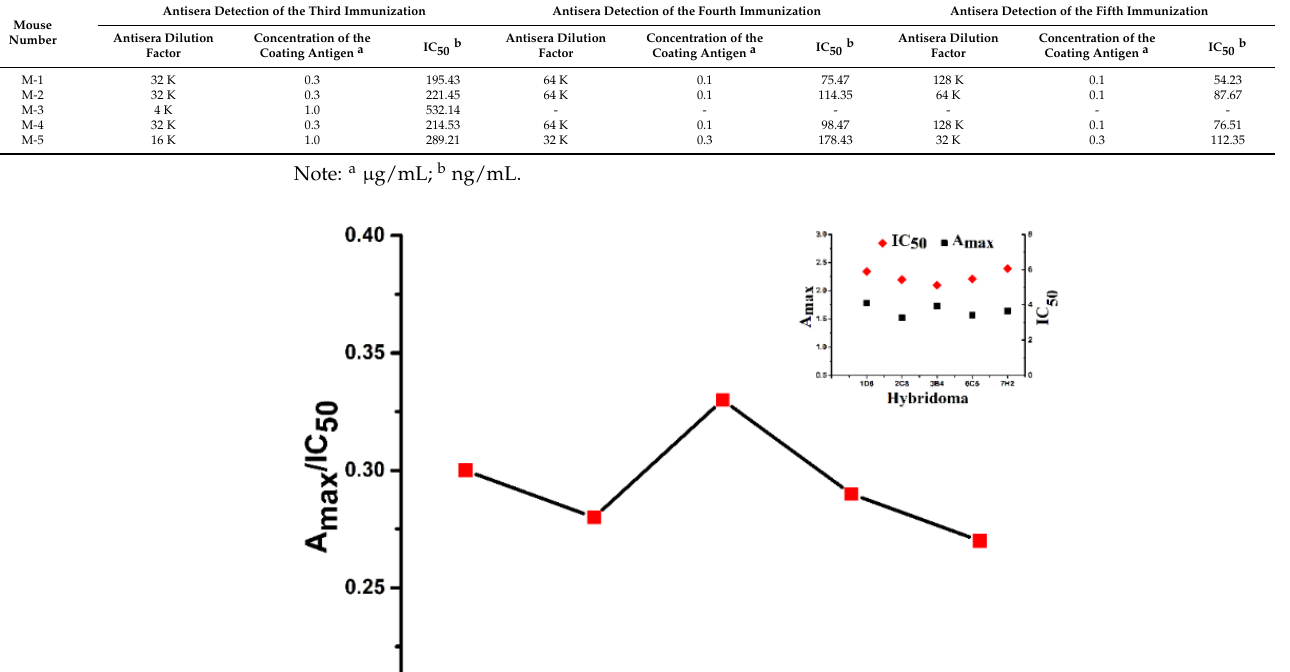
Figure 7. Characterization of the hybridoma antibody. ( A ) Isotype determination of mAb. ( B ) Affin- ity constant result of mAb. 3.5. Development and Optimization of the ic-ELISA The ic-ELISA was optimized under the optimal analysis condition, with the coating antigen and mAb concentrations for 0.1 μg/mL and 0.31 μg/ mL, respectively. The pH val- ues were known to affect the available number of sites of the antigen-antibody reaction, while the NaCl content could affect the charge of the epitope and paratope groups and then limit the antigen-antibody reaction. As endosulfan was extracted by methyl alcohol, the sensitivity of the ic-ELISA would be affected by the solvent. As shown in Figure 8 and Table 2, this optimum condition was reached at pH 7.2, which gave the lowest IC 50 value of 5.55 ng/mL, and the highest A max /IC 50 ratio of 0.27. 5% methyl alcohol was selected as the ideal condition with the lowest IC 50 value of 5.67 ng/mL and with the highest A max /IC 50 ratio of 0.27. With regard to the NaCl content, the IC 50 was not the lowest value at 0% for the NaCl content, but it gave the highest A max value and the highest A max /IC 50 ratio. In